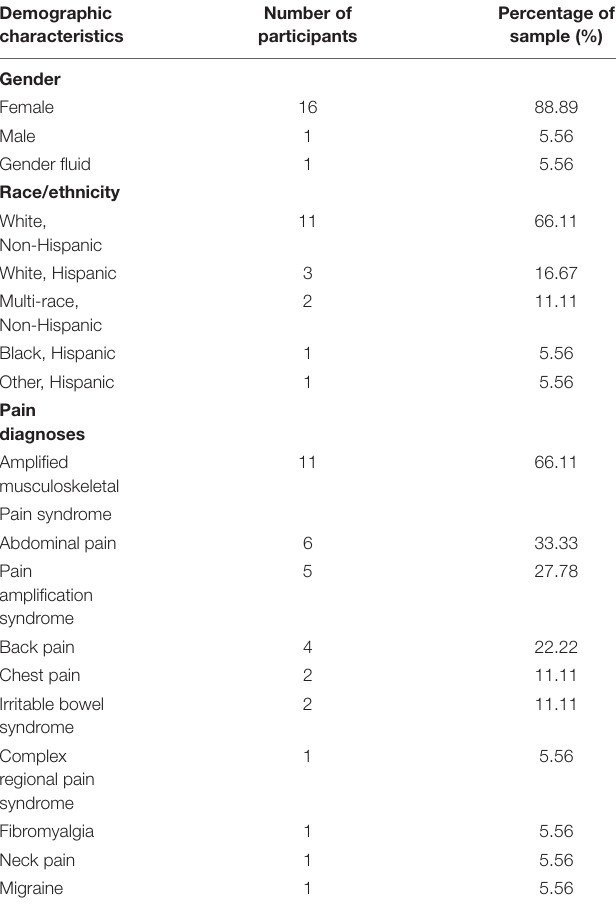
TABLE 1 | Demographic information for adolescent participants ( N =